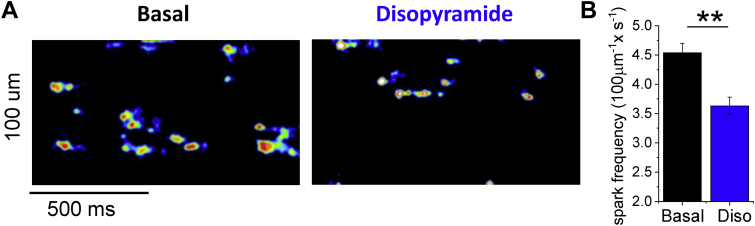
Effects of 5 μmol/l of Disopyramide on Ca Sparks in Permeabilized Myocytes(A) Calcium sparks in permeabilized cardiomyocytes from the left ventricle of transgenic hypertrophic cardiomyopathy mice (R92Q-TnT mutation): the representative kymographic images show confocal line scans traced along the longitudinal cell axis, displaying fluorescence signals from the Ca-selective dye, recorded at a speed of 512 lines/s while bathing the permeabilized myocytes in an intracellular solution containing 150 nmol/l [Ca2+] at room temperature. Spontaneous Ca sparks are visible as spontaneous elevations of local [Ca2+] signal lasting 20 to 40 ms. Representative traces from cells in the absence (left) and presence of disopyramide (Diso) (right) in the bathing solution. Kymographic images are reported in false color (16-colors lookup table) after thresholding and filtering (Gaussian smoothing with 2px sigma). (B) Frequency of spontaneous Ca sparks per 100 μmol/l of scanned line length, in the absence and presence of 5 μmol/l disopyramide. Mean ± SEM from 74 cardiomyocytes (basal) and 63 cardiomyocytes (disopyramide) isolated from 4 mouse hearts. **0.01 > p > 0.001, unpaired Student’s t-test.